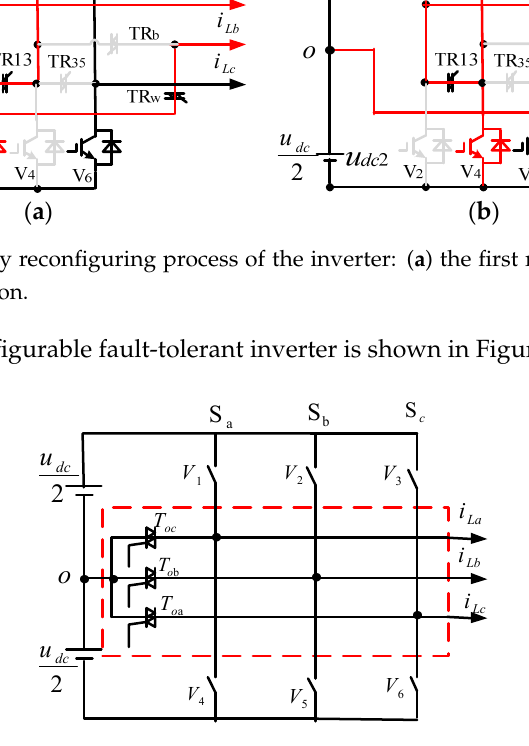
Figure 3. The traditional reconfigurable fault-tolerant inverter.